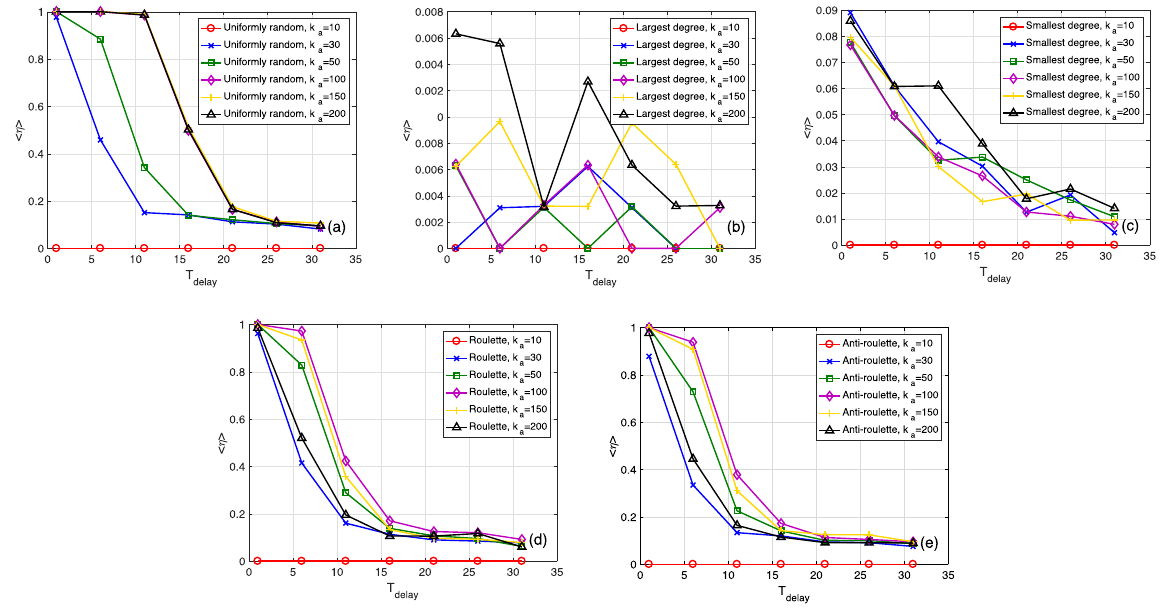
Figure 3. Mean survival ratio 〈 η 〉 as a function of T delay for N a = 100 and different k a values. ( a ) ER networks with the uniformly random selection. N = 1000, M = 1000, M a = 10, 〈 k 〉 = 20, k s = 11, q = 0.09, and f = 0.1. The threshold for determining a total collapse is d = 0.5. ( b–e ) Similar to (a) but for the largest degree, smallest degree, roulette, and anti-roulette selection